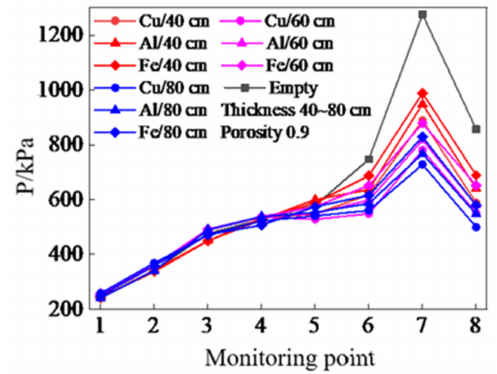
Figure 13. Maximum overpressure at each monitoring